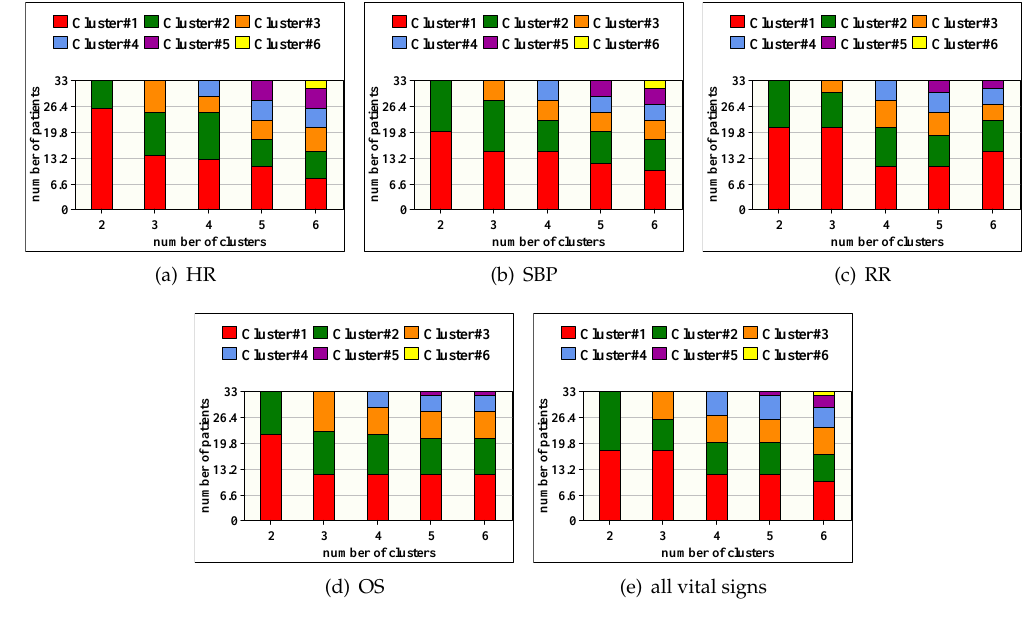
Figure 5. Distribution of patients over